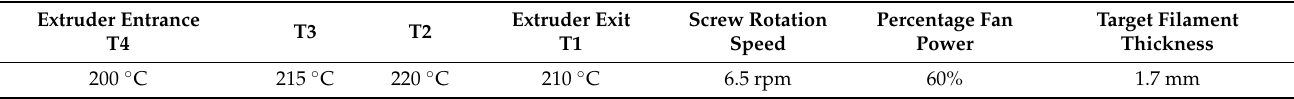
Table 1. Settings of the 3DEVO Next 1.0—ADVANCED filament maker. T1, T2, T3, and T4 represent the temperatures of the different heating zones of the extruder section of the filament maker, where T1 is the extruder section closer to the exit. Extruder Entrance